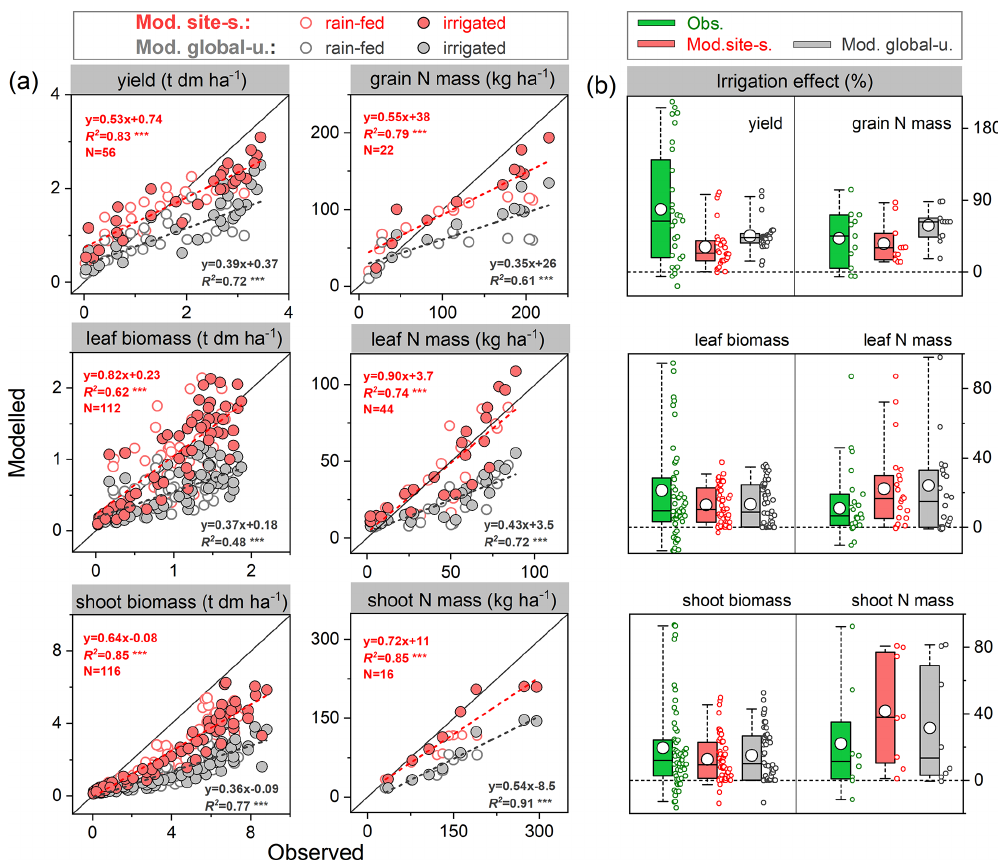
Figure 5. Comparison of modeled and observed soybean tissue biomass and N mass (a) and their responses to irrigation management (b) compared with those grown at rain-fed conditions. Red and grey circles depict “site-specific” and “global uniform” run, respectively; the dashed line is fitted linear regression; ∗∗∗ denotes the regression statistically significant at p = 0 . 001. Box plots in (b) denote the 5th and 95th percentiles with whiskers, median and interquartile range with box lines, and mean with a white dot (all data distributed next to the box). The seasonal data at each phenological stage for tissue biomass are available from 1978–1979 and 1984–1985 with rain-fed and irrigated treatments; those for N mass are available for 1979 and 1984, while the seasonal shoot N mass is only available for